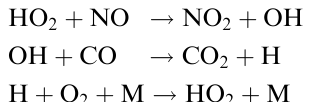
Fig. 2. Air spectrum in the wavelength region 344–434 nm for the evaluation of NO 2 , path length 4200 m ( trace a ). Lamp spectrum ( b ), O 4 spectrum ( c ) and atmospheric absorption by 1.35 ppb NO 2 ( d ). The shaded area was excluded from the fit because of large lamp structures. Trace e shows the atmospheric NO 2 spectrum obtained from the air spectrum by taking out the fitted lamp structures and the species absorption of O 4